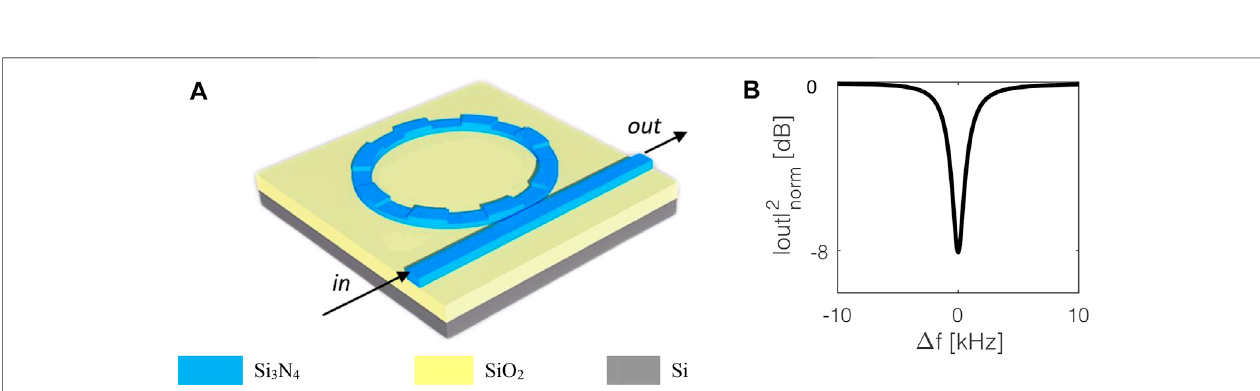
FIGURE7 | Schematic ofSi 3 N 4 RR (A) and its spectrum (B) ( Δ f : frequency detuning = f - f osc ; |out| 2 norm : output power normalized with respect tothe inputpower in ).